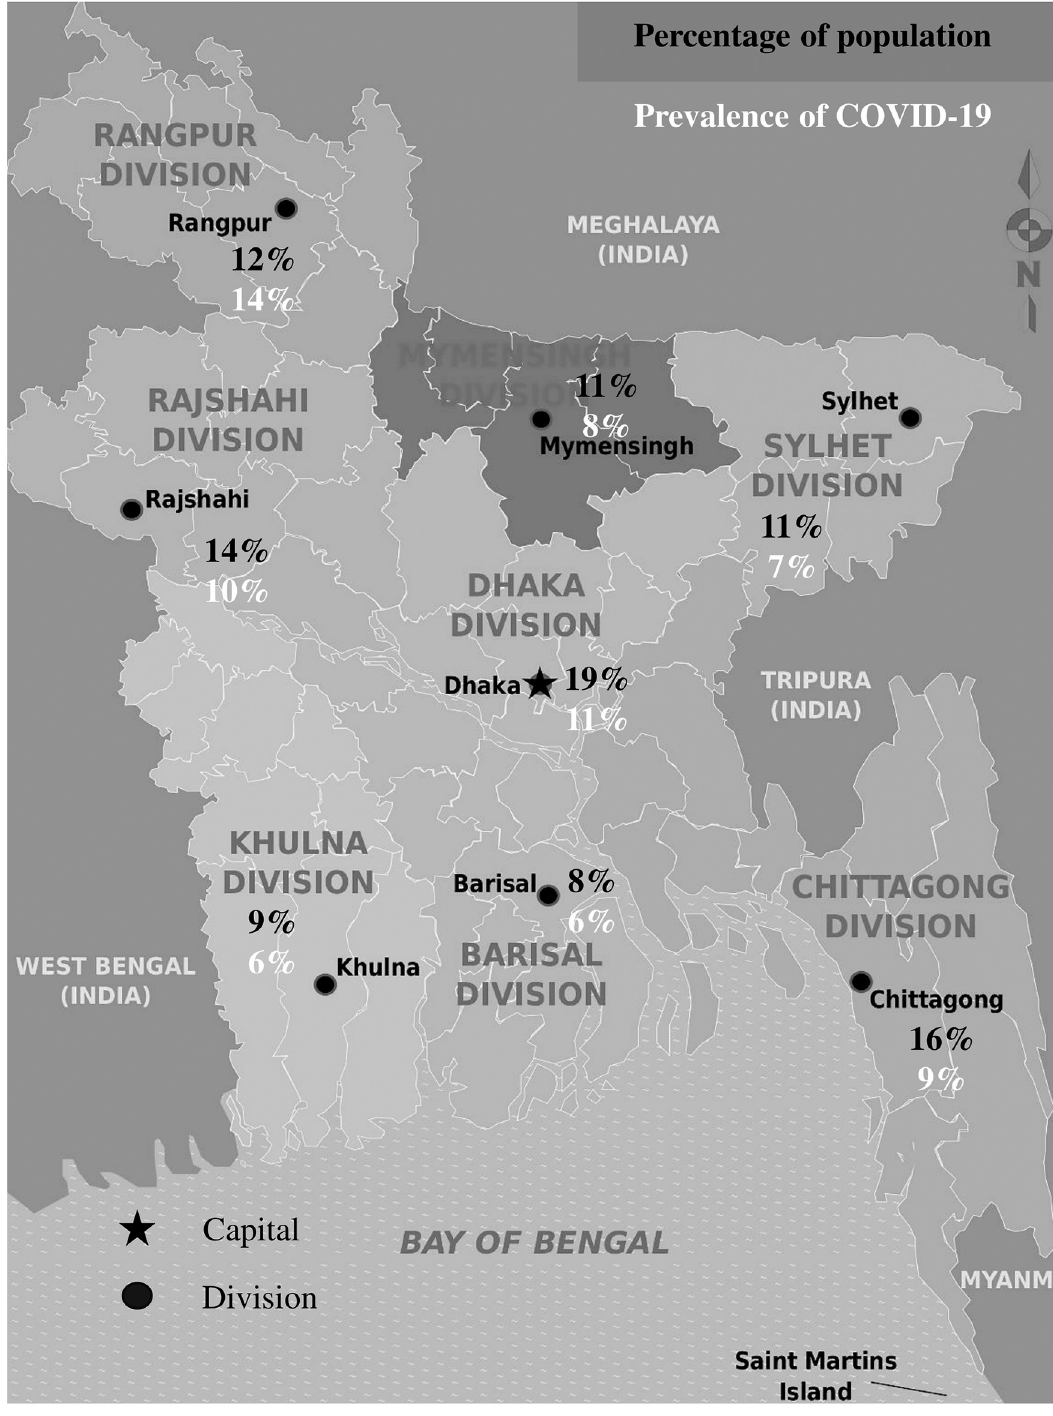
Fig 1. Frequency distribution of the study participants and prevalence of COVID-19 in Bangladesh.